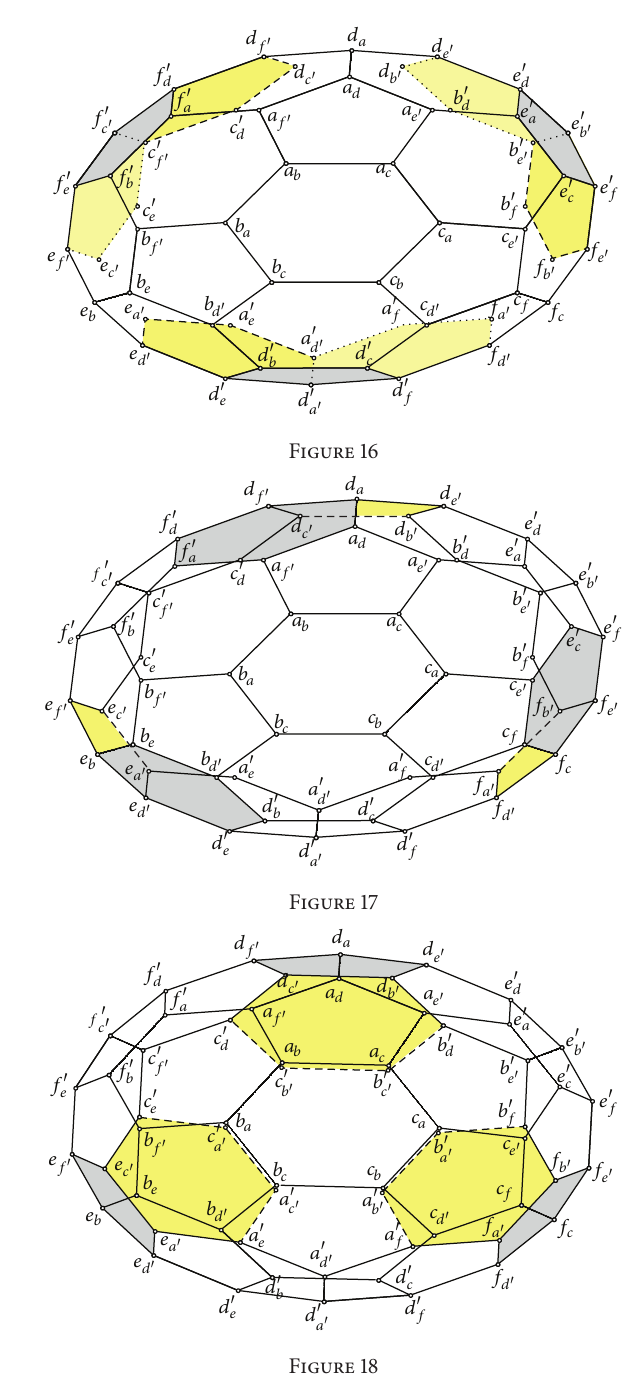
ARH (𝑎 𝑑 , 𝑎 𝑒 󸀠 , 𝑒 󸀠 𝑎 , 𝑒 󸀠 𝑑 , 𝑑 𝑒 󸀠 , 𝑑 𝑎 ) , and similarly we get ARP 𝑒 , 𝑒 , 𝑒 , 𝑒 ) and ARP (𝑓 (𝑒 𝑑 󸀠 , 𝑎 󸀠 𝑐 󸀠 𝑓 󸀠 𝑏